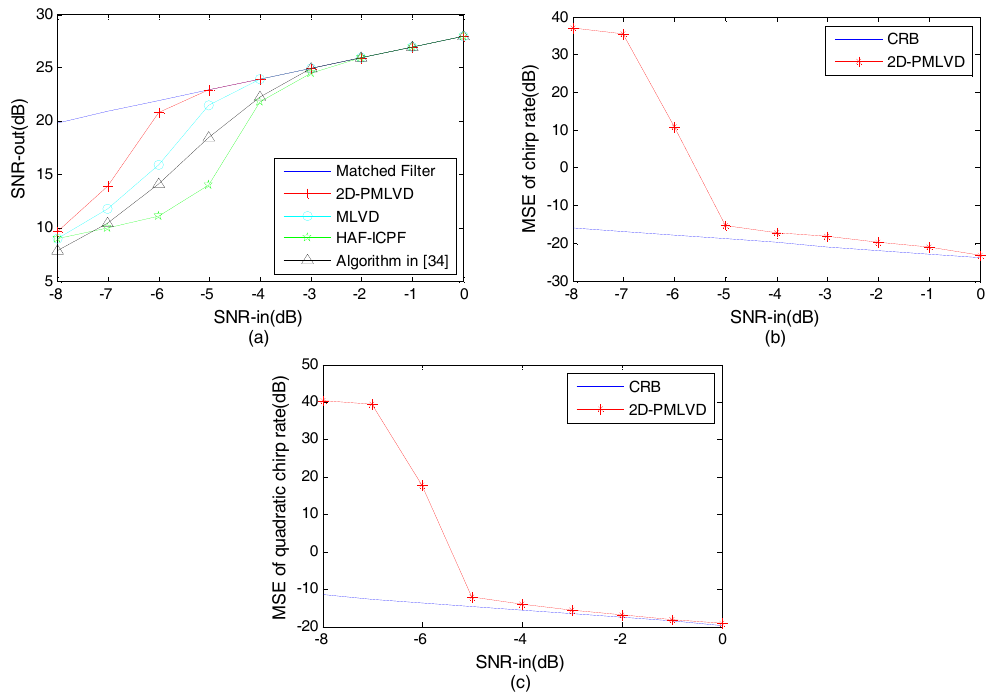
Figure 4. Anti-noise performance analysis. ( a ) Input-output SNR comparison; ( b ) MSE of the chirp rate estimation; ( c ) MSE of the quadratic chirp rate estimation.